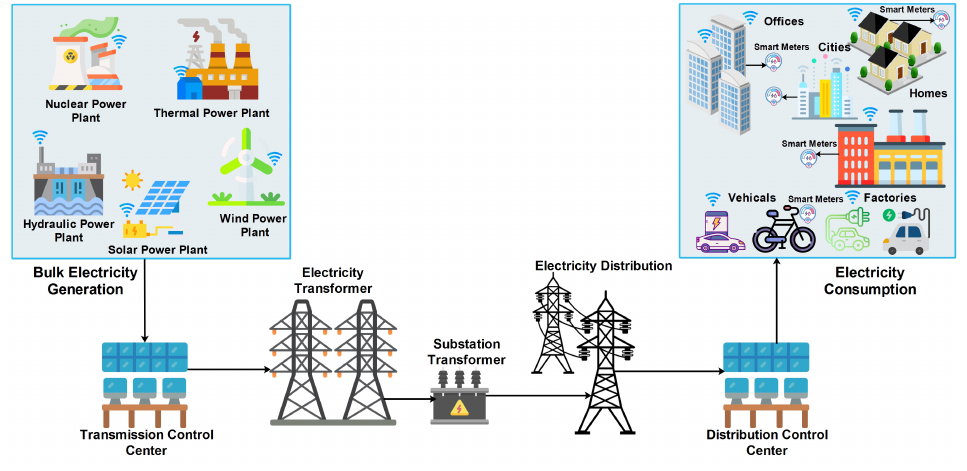
Figure 1. Characteristics of smart